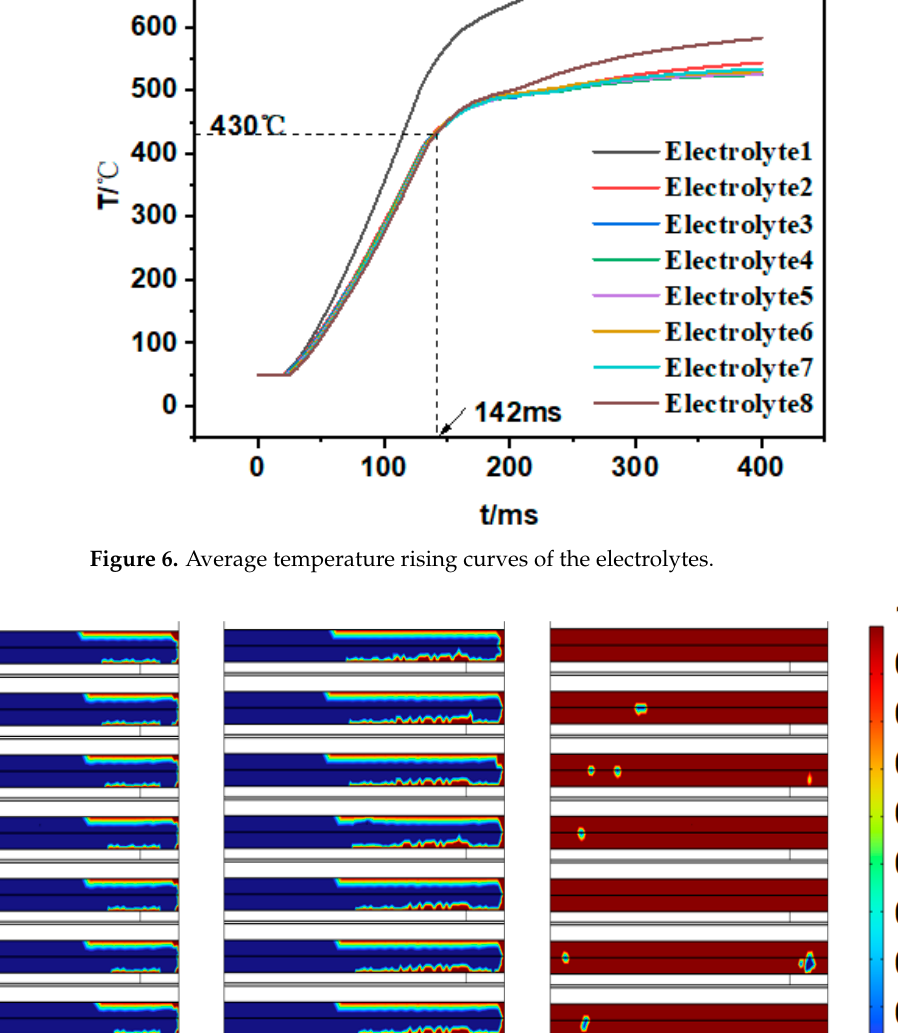
Table 2. Thermal battery activation ‐ phase curve (time to reach the following voltages, unit ms) .